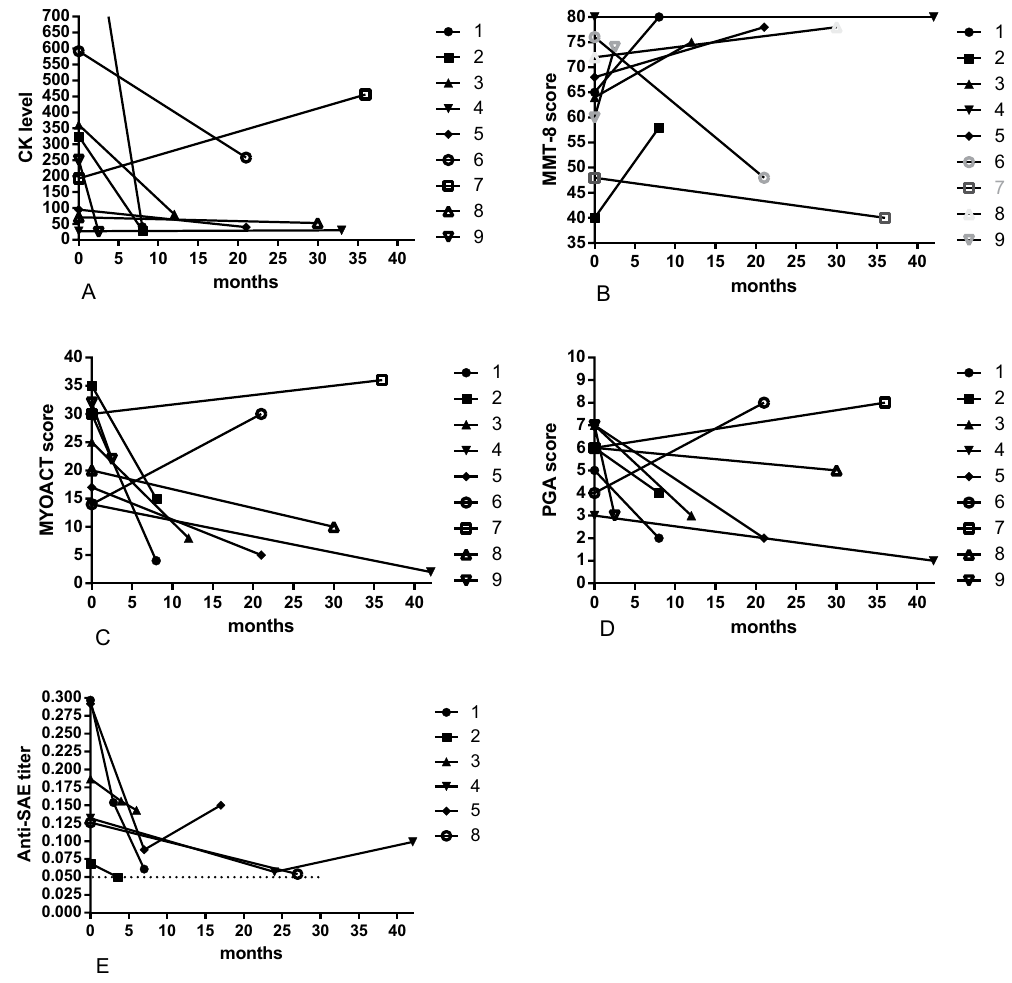
Figure 2. Follow-up findings from anti-SAE antibody-positive patients. CK levels ( A ), MMT-8 scores ( B ), MYOACT scores ( C ), PGA scores ( D ), and anti-SAE antibody levels ( E ) at baseline and after